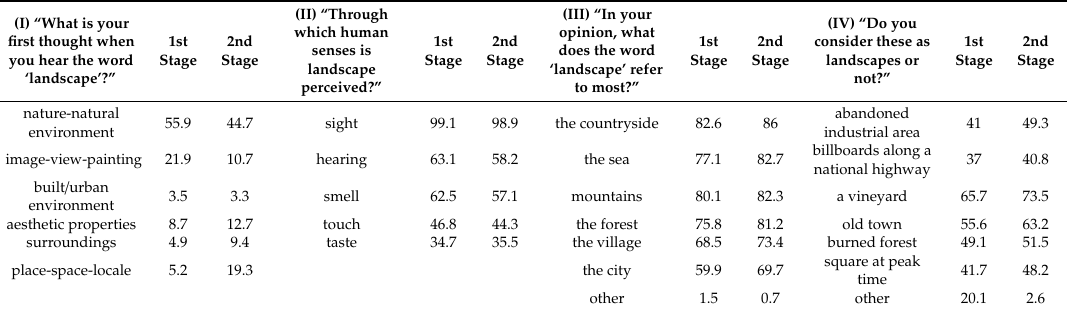
Table 1. Greek engineering students’ landscape perceptions (1st and 2nd research